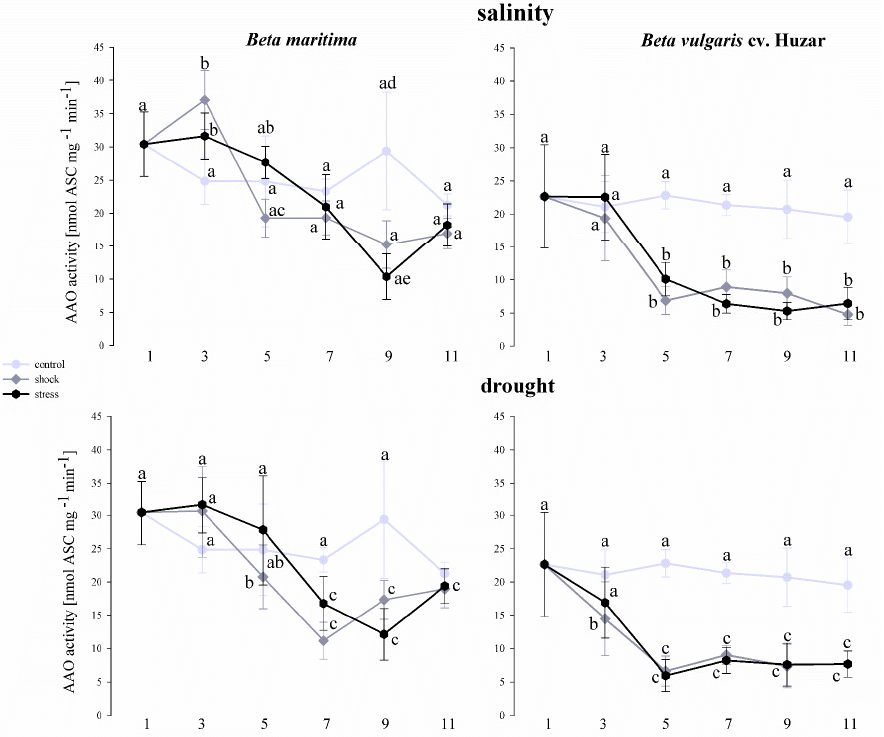
Figure 10. AAO activity determined in leaves of Beta vulgaris ssp. maritima and Beta vulgaris cv. Huzar subjected to salt shock or salt stress and drought shock or drought stress. Control − light gray bars, salt shock − gray bars, salt stress − black bars. Different letters denote significant differences at p < 0.01 (ANOVA followed by Tukey’s test). “Whiskers” indicate standard deviation.